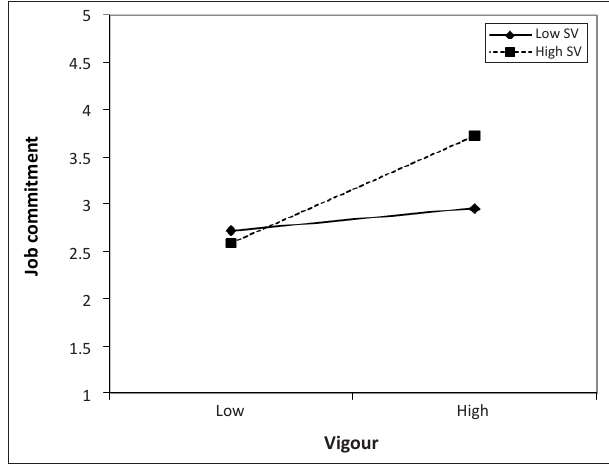
FIGURE 1: Service/dedication to a cause (SV) as a moderator of the relationship between vigour (work engagement) and job commitment.